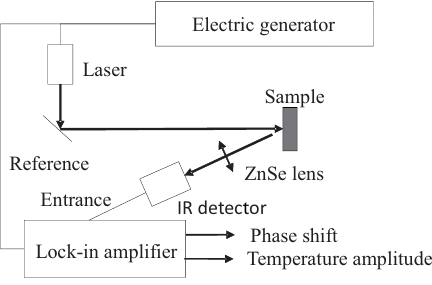
Fig. 4. Scheme of the experimental setup.